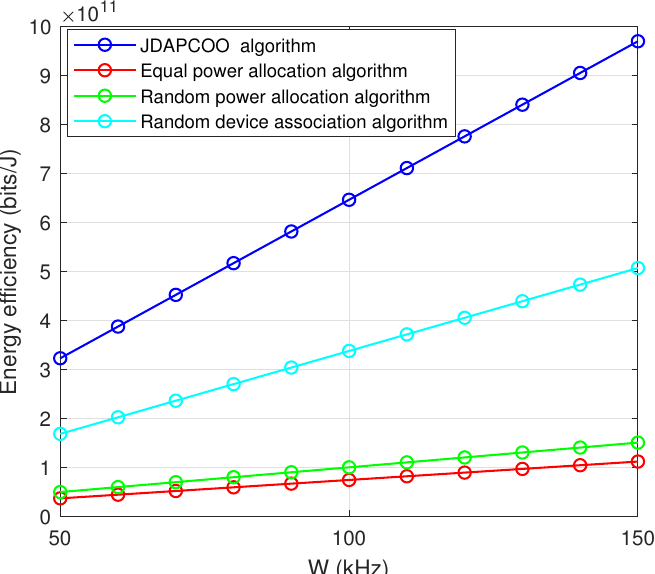
Figure 9. The relationship between the total system energy efficiency and the channel bandwidth.